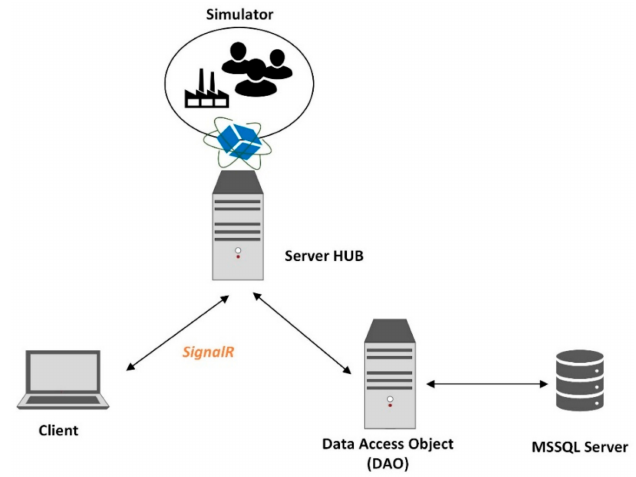
Figure 10. Software Architecture Scheme.